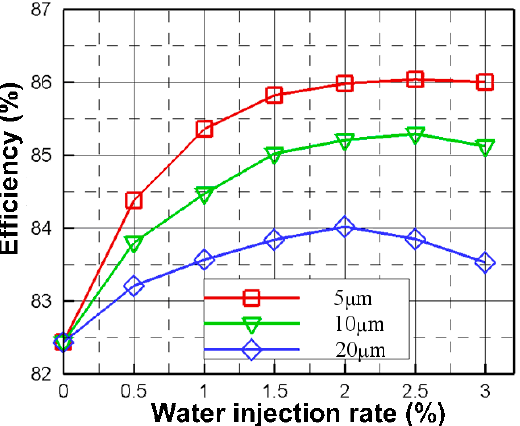
Figure 19. Comparison of total specific compression work under dry and water injection cases.